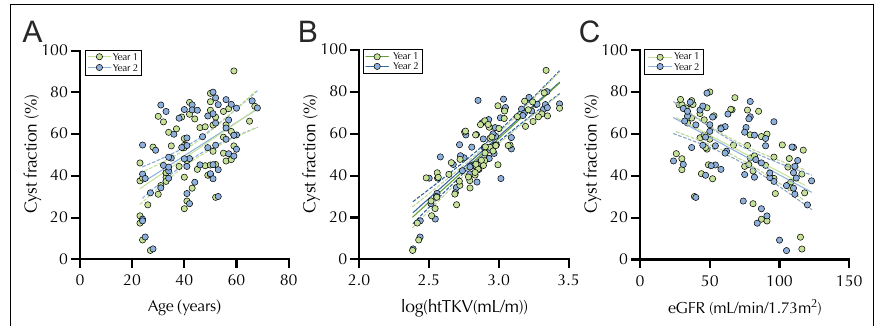
among ADPKD patients for year 1 ( A , C ) and year 2 ( B , D ). CKD, chronic kidney disease. The grey area in ( A – D ) depicts the medium cyst fraction (35–70%).